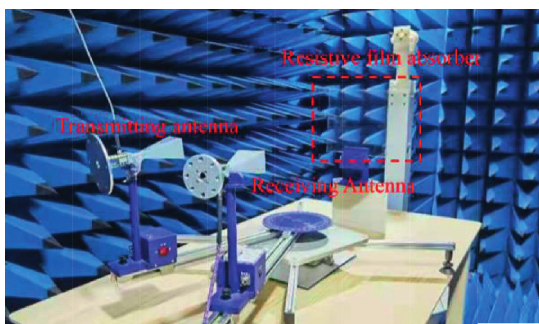
Figure 21: Photograph of the experiment setup.